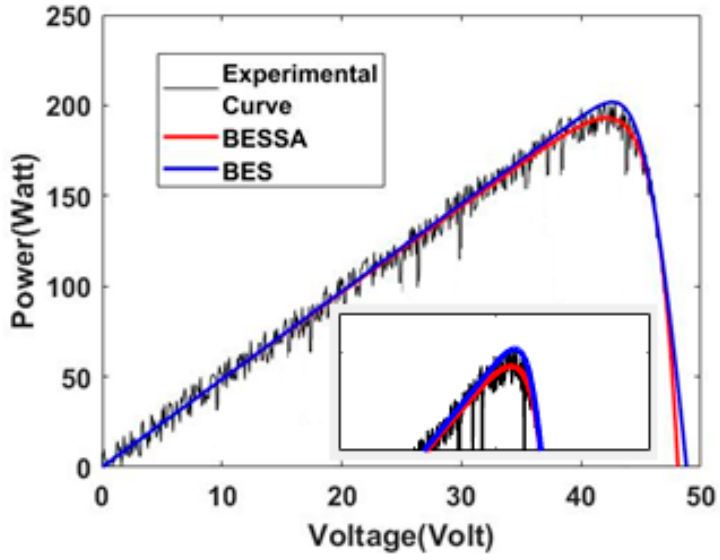
Figure 15. Simulation and experimental results for the PV curve of Module AS ‐ M3607 ‐ S at a tem ‐ perature of 28 °C and an irradiance of 480 W/m 2